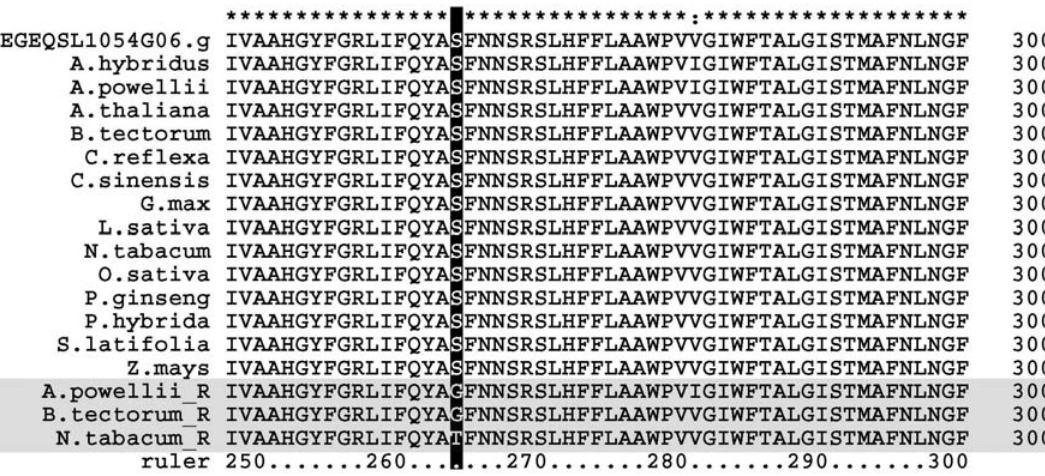
Figure 2 - Alignment of sequences of Protein D1 from different higher plant species.